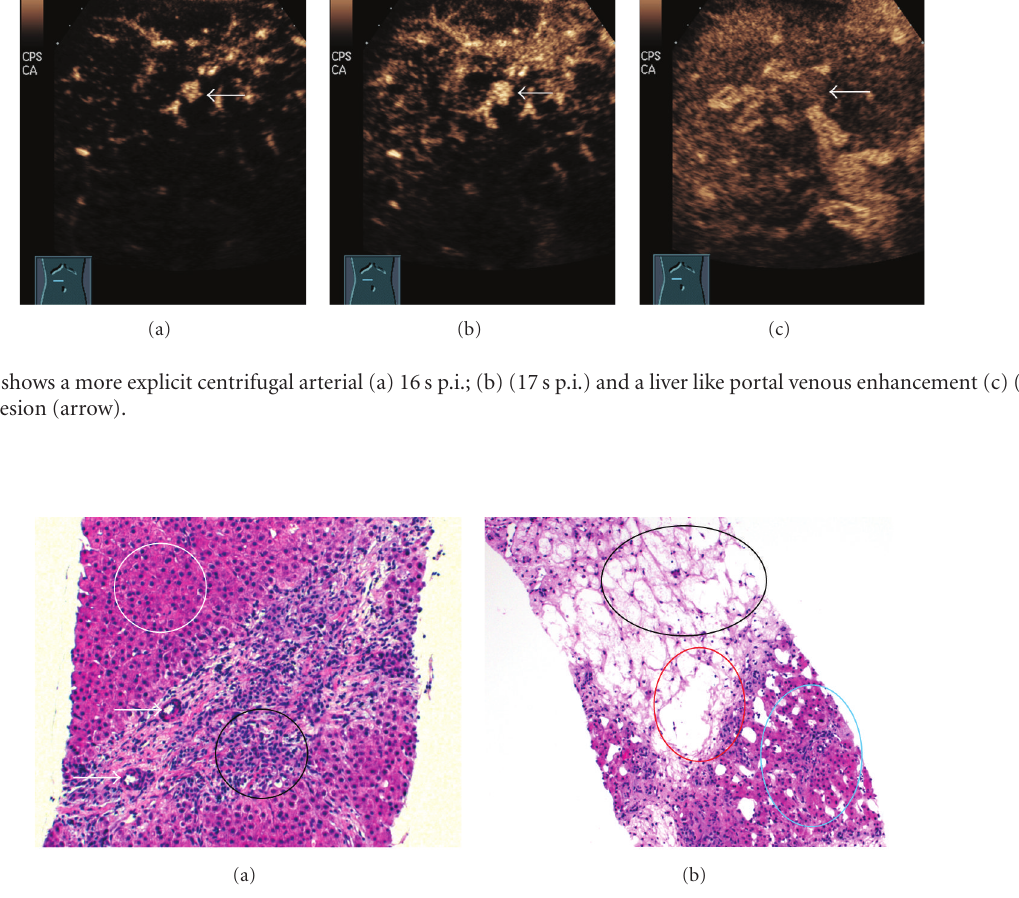
Figure 4: Histological preparation: (a) thickened arterial vascular wall (arrows), proliferation of bile ducts and of inflammatory cells (black), and normal hepatocytes/liver parenchyma (white) (b) dropout of hepatocytes as a sign of cirrhosis of the liver, liver vein (red), and normal liver parenchyma (light